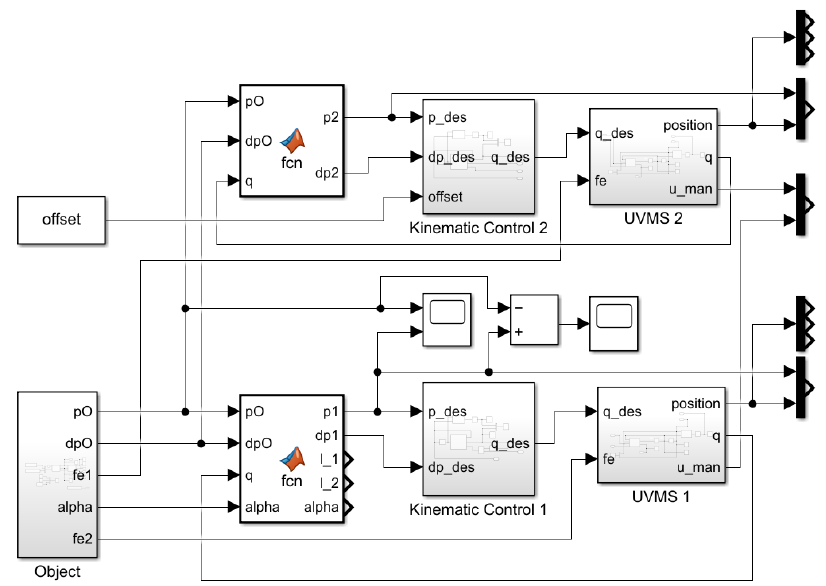
Figure 7. Simulink model for the two UVMSs.